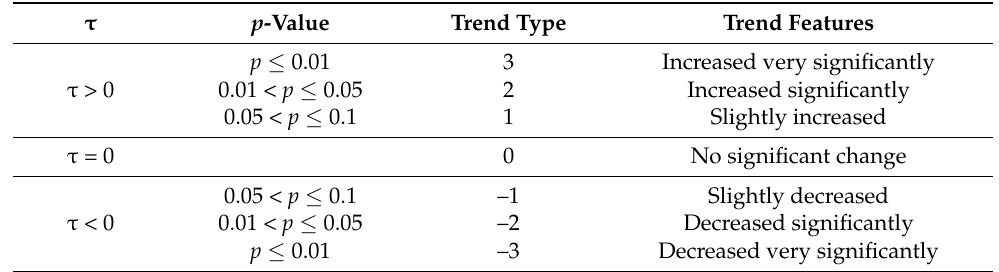
Table 2. Trend classification in terms of p -value and τ using the Mann–Kendall (MK) trend test.